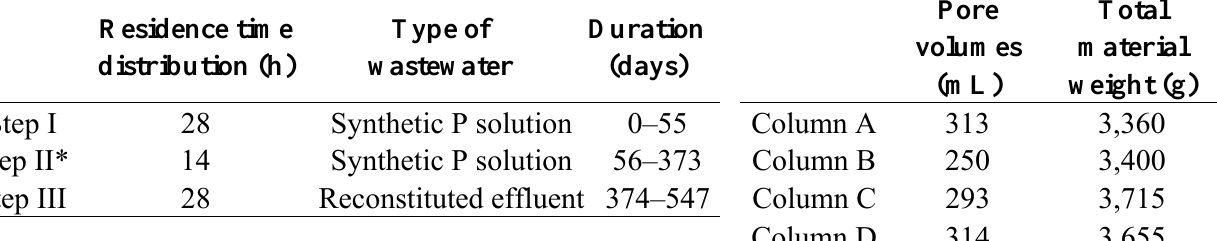
Table 1. Details on the three steps investigated and columns